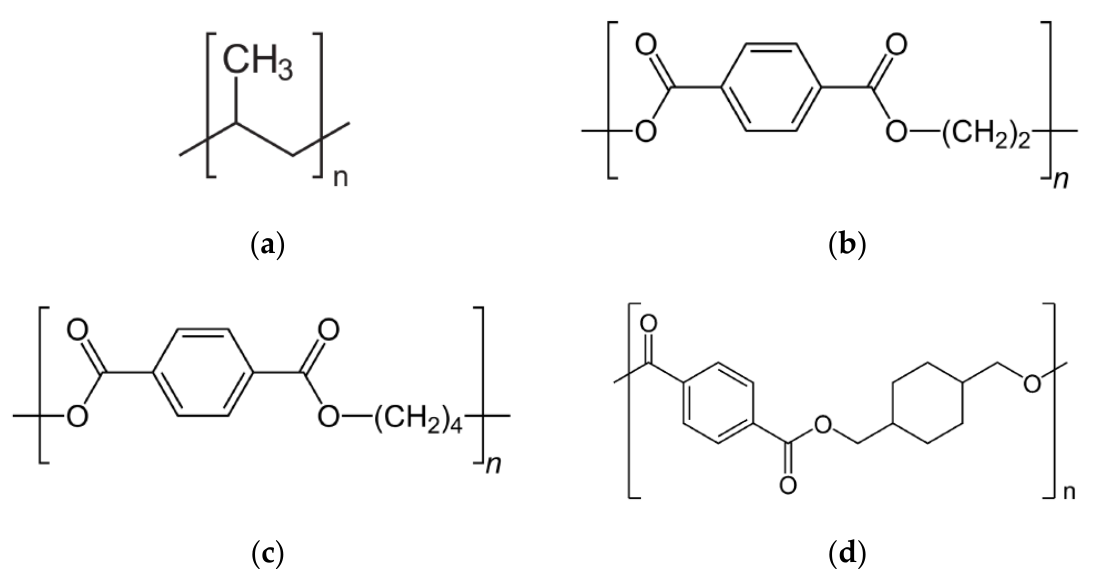
Figure 6. Reference materials for IR database: ( a ) Polypropylene (PP), ( b ) polyethylentere phthalate (PET), ( c ) polybutylene terephthalate (PBT), and ( d ) polycyclohexylenedimethylene terephthalate (PCT).